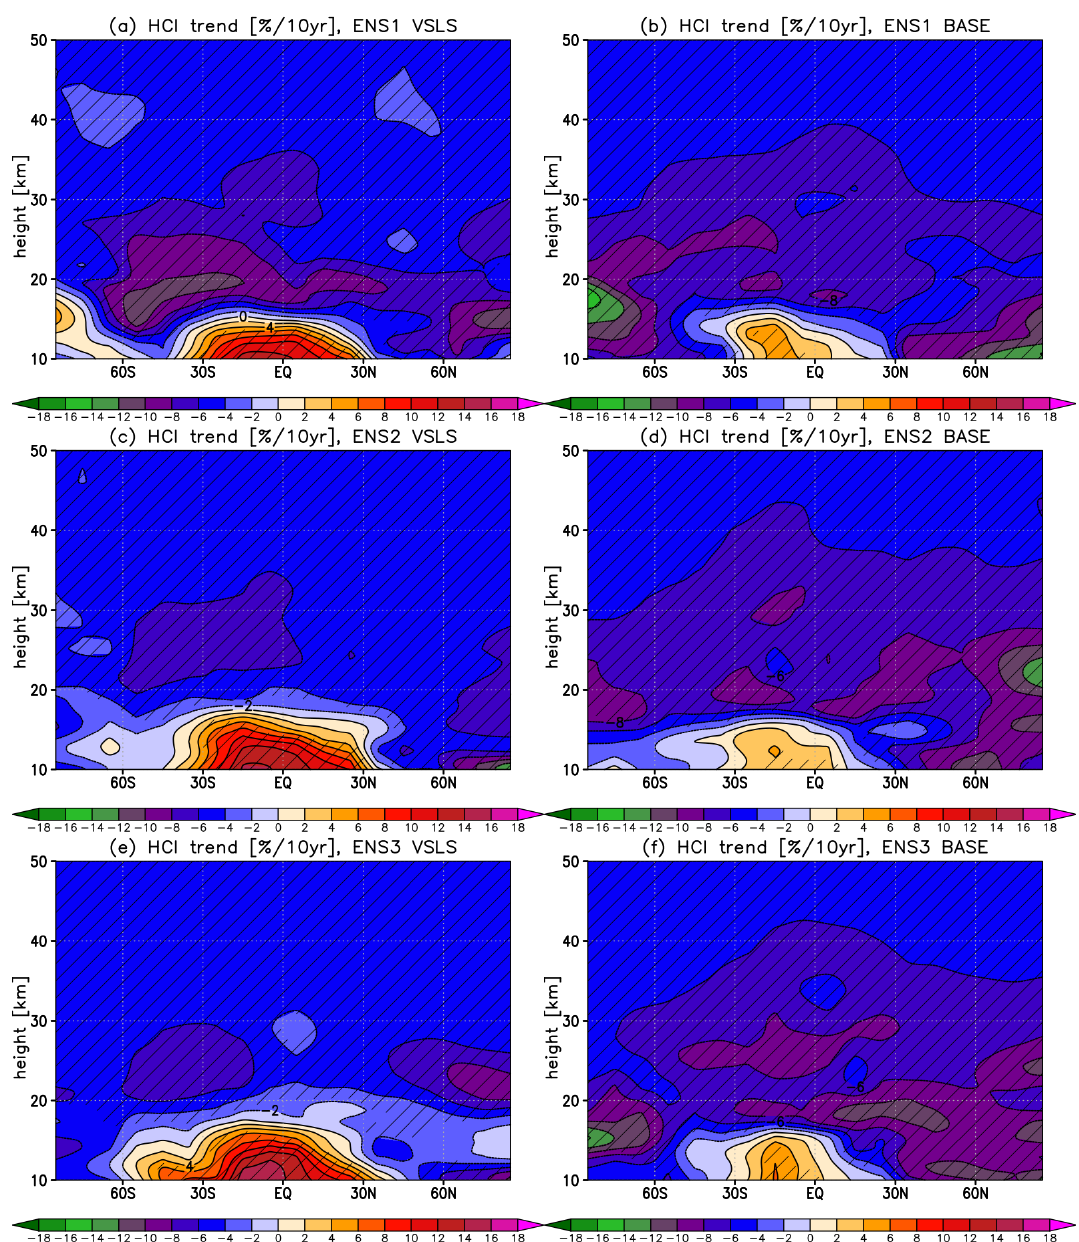
Figure 11. Linear MAM2004-SON2019 trends in deseasonalised HCl mixing ratios [% per 10 years] derived from the individual VSLS ensemble members: (a) ENS1 VSLS, (c) ENS2 VSLS and (e) ENS3 VSLS, and from the individual BASE ensemble members: (b) ENS1 BASE, (d) ENS2 BASE and (f) ENS3 BASE. Hatching indicates statistical significance (as in Fig.